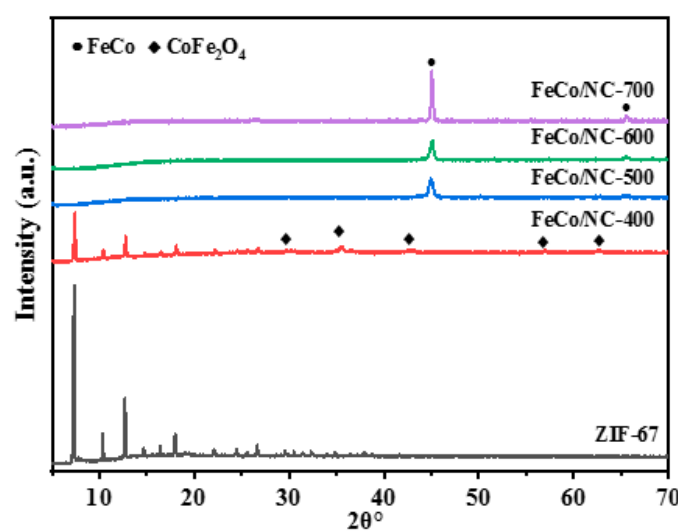
Figure 3. XRD images of fresh FeCo / NC-T catalysts. Figure 3. XRD images of fresh FeCo/NC-T catalysts. Figure 3. XRD images of fresh FeCo/NC-T catalysts.